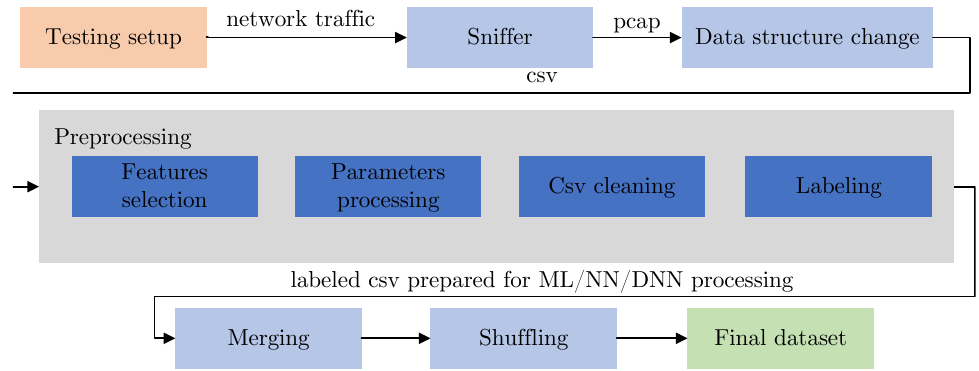
Figure 3. Data-preprocessing flow to create the final